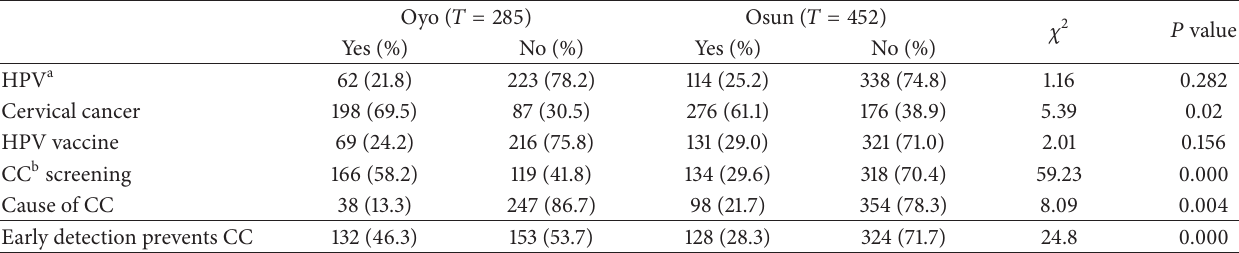
Table 2: Knowledge of HPV, HPV vaccine, and Pap smear